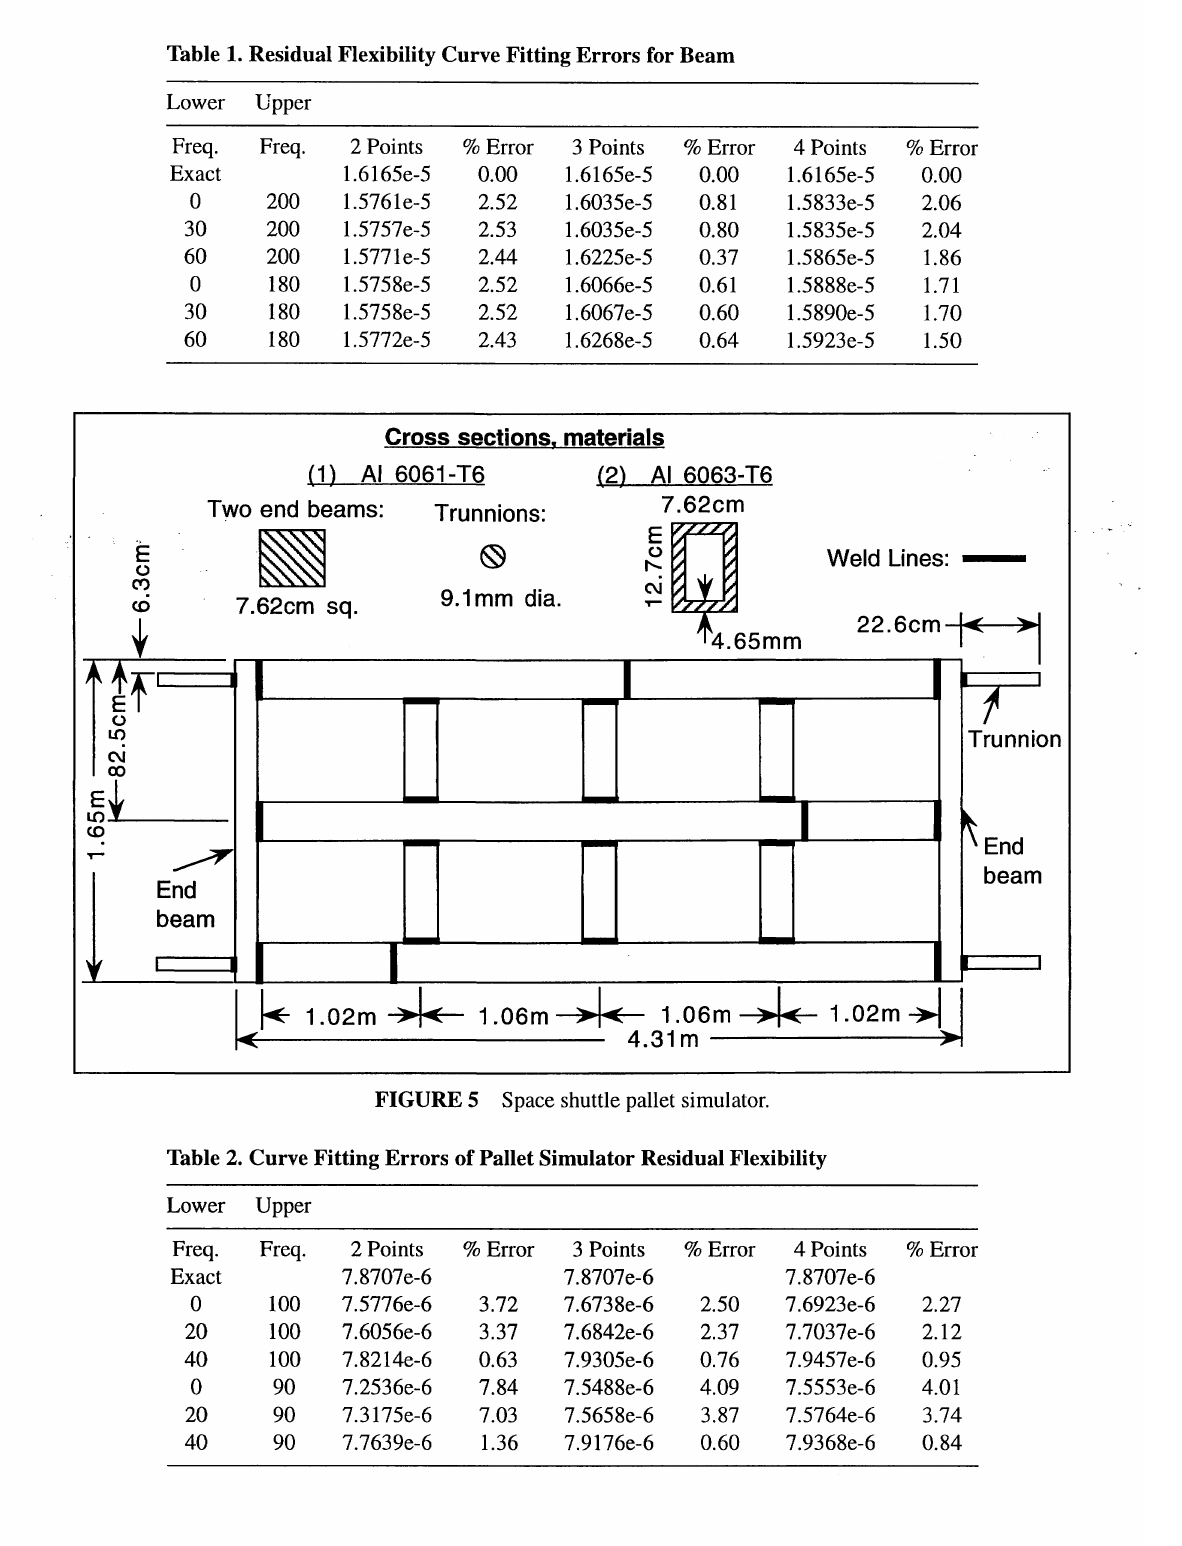
Table 1. Residual Flexibility Curve Fitting Errors for Beam Lower Upper